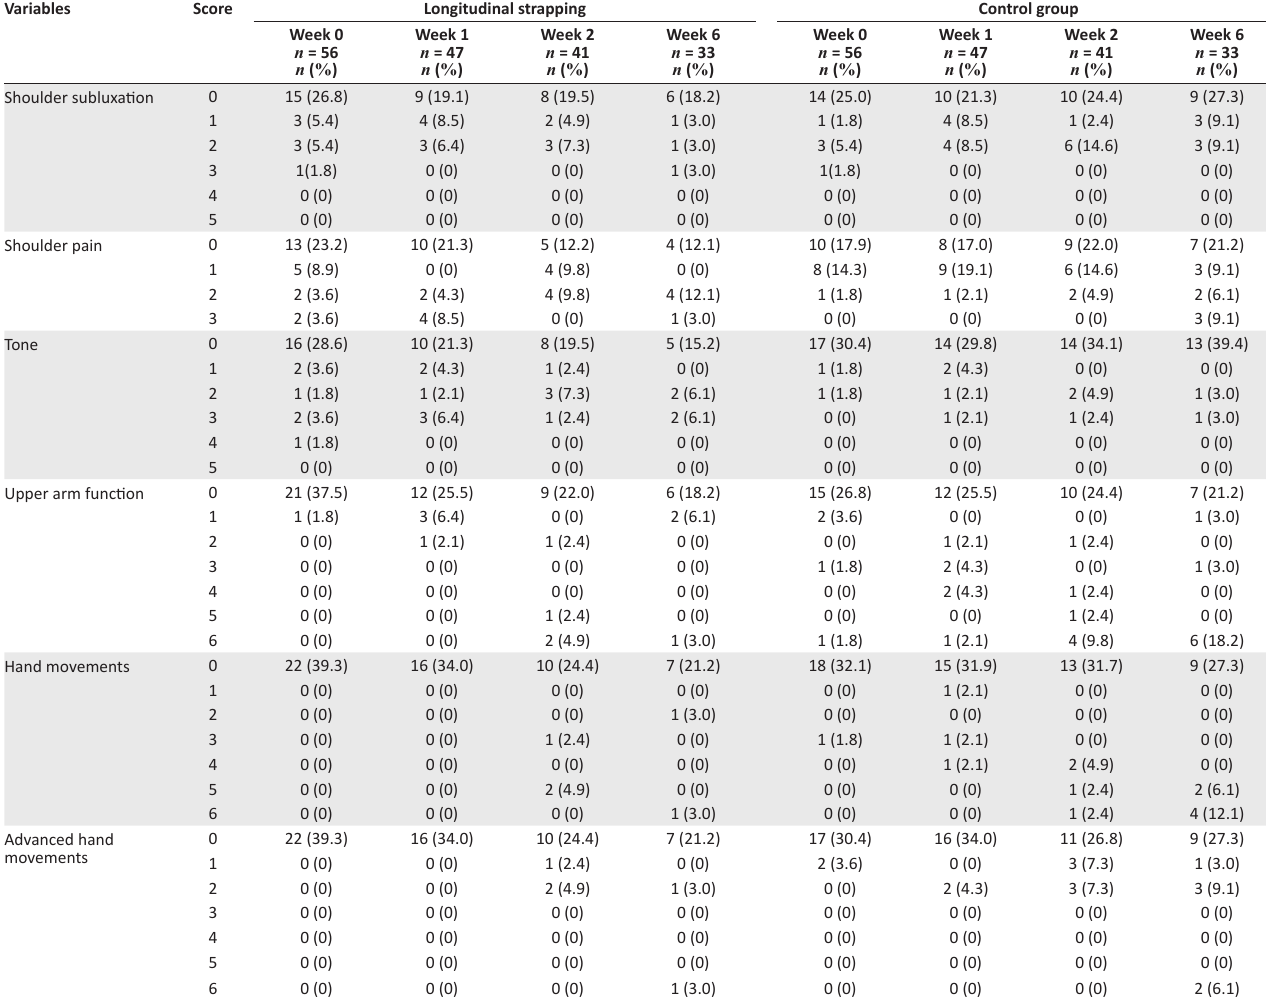
FIGURE 4: Distribution of participants’ upper limb changes over 6 weeks. TABLE 4: Changes in outcomes between the longitudinal strapping and the control group over a 6-week